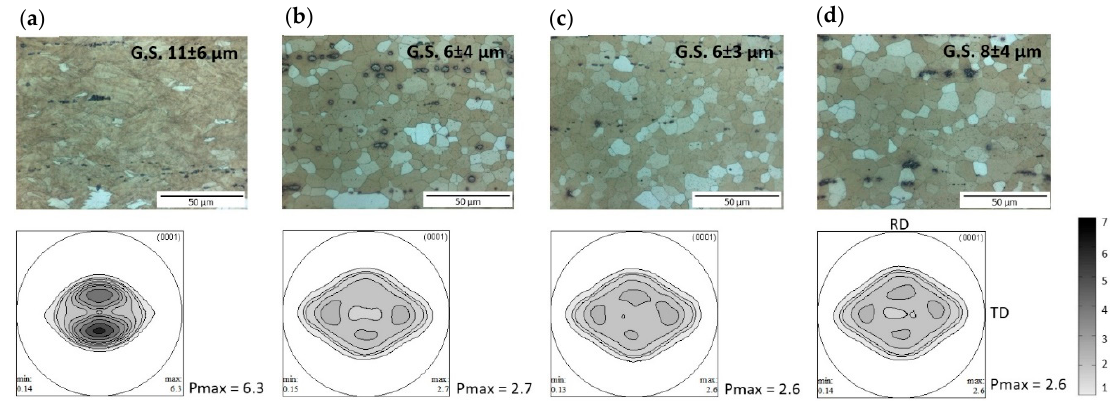
Figure 1. The optical micrographs and the recalculated (0002) pole figures of the sheets rolled by the 450-inc rolling scheme, i.e., the increasing deformation degrees with rolling step, ( a ) at the as-rolled condition and after annealing for ( b ) 300 s, ( c ) 600 s and ( d ) 3600 s at 400 °C.